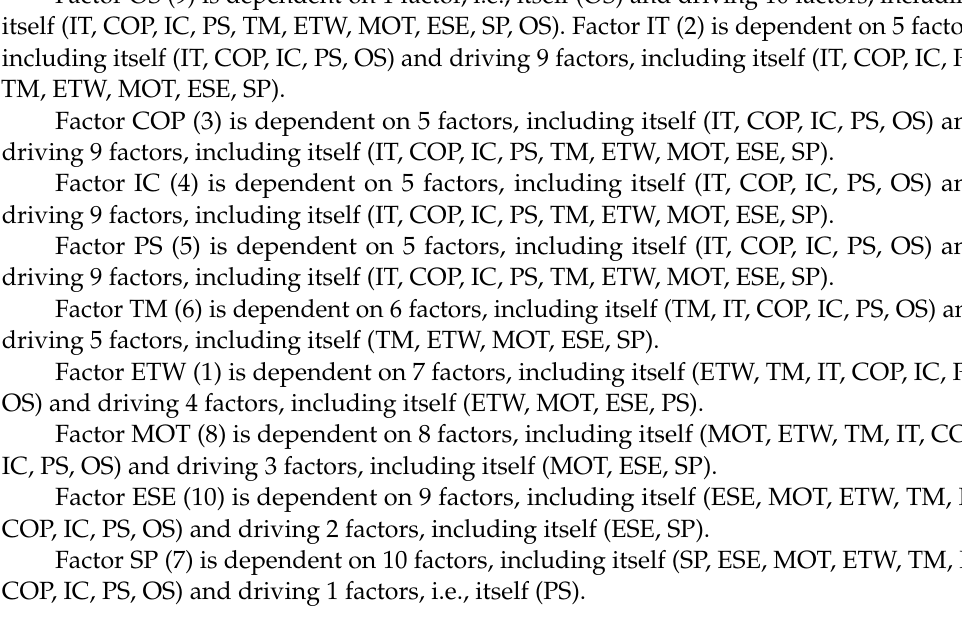
Figure 2. ISM multilevel hierarchy model. (Source: Survey data and author’s